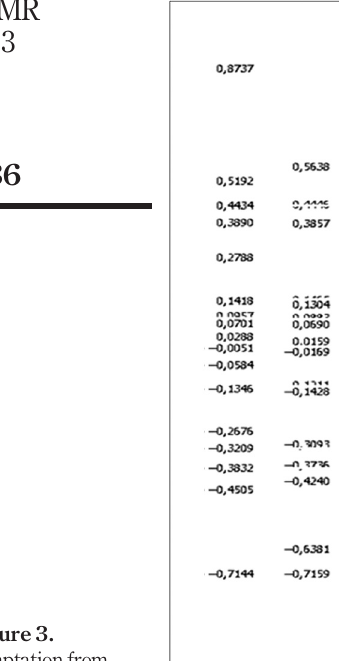
Figure 3. Adaptation from GAIA with net fl ow